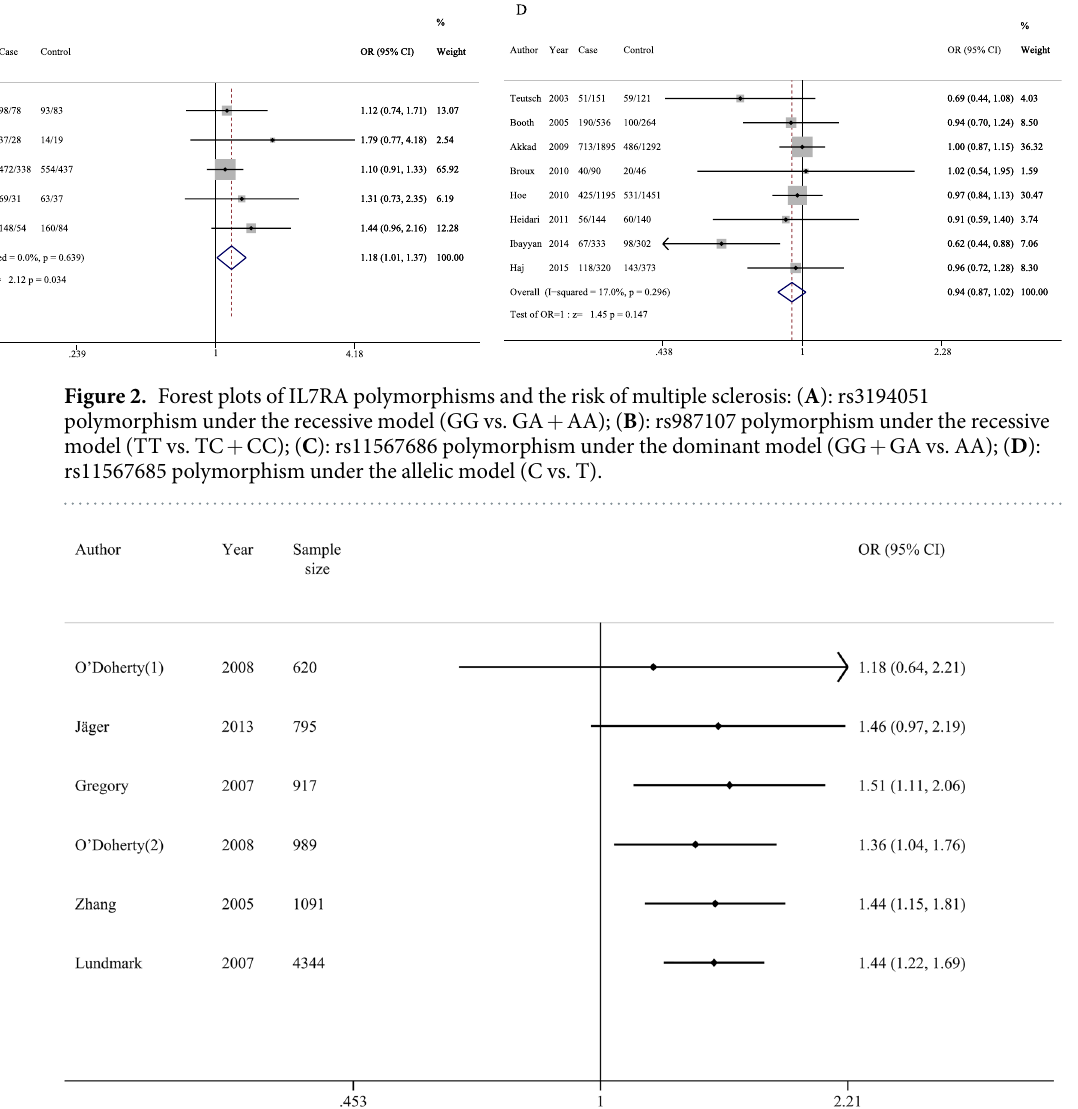
Figure 3. Forest plot of cumulative meta-analysis by sample size about the association between the rs987107 polymorphism and MS risk under the recessive